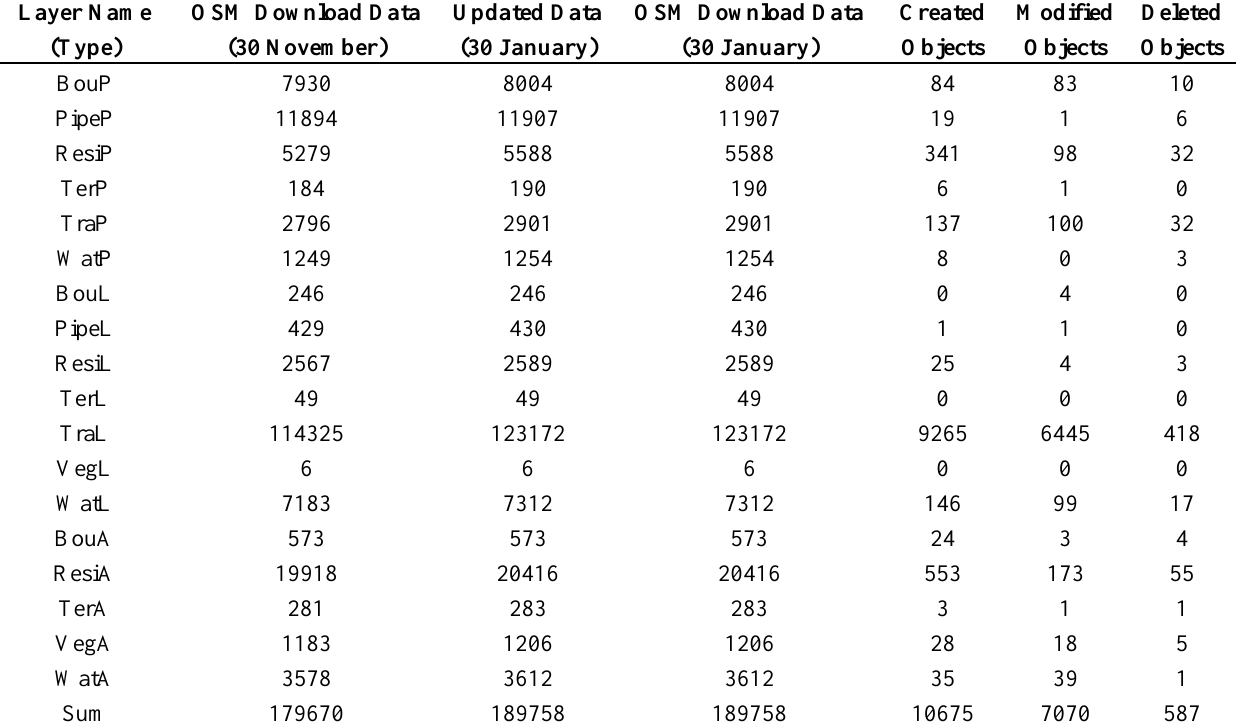
Figure 7. The incremental updating experiment using OsmChange data. ( a ) The Pakistan data converted from OSM for 30 November 2014; ( b ) the change-only data from 30 November 2014 to 30 January 2015; ( c ) the updated data of Pakistan at 30 January 2015. Table 4. The distribution of the objects in the updating